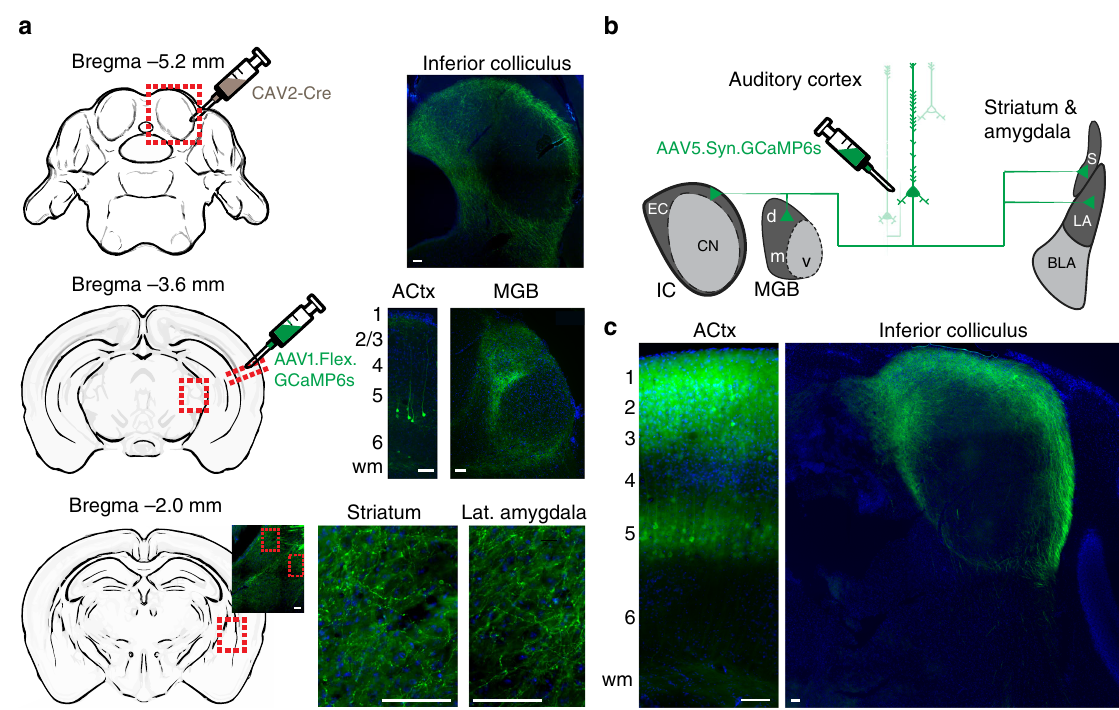
Fig. 1 Auditory corticofugal neurons that innervate the inferior colliculus have other widespread targets throughout the forebrain. a A canine adenovirus vector with ef fi cient retrograde transport (CAV2) was injected into the IC to express cre-recombinase in neurons that project into the injection zone. A cre-dependent AAV was then injected into the ipsilateral ACtx to express a fl uorescent marker throughout the entire axon fi eld of CCol neurons. Photomicrographs show the expected labeling of layer 5 ACtx neurons and their IC axon terminals, with additional strong axon labeling in the dorsal nucleus of the medial geniculate body, lateral amygdala and posterior regions of the dorsal striatum. wm white matter. b Schematic of virus strategy used for in vivo Ca 2 + imaging in corticofugal axons. EC and CN are external cortex and central nucleus of the IC, respectively. MGB subdivisions d, v and m are dorsal, ventral and medial, respectively. LA and BLA are lateral and basolateral amygdala, respectively. S is striatum. c Strong labeling of L5 pyramidal neuron cell bodies, apical dendrites and CCol axon terminals are observed approximately 5 weeks after injection of the GCaMP6s virus in ACtx. All scale bars = 0.1